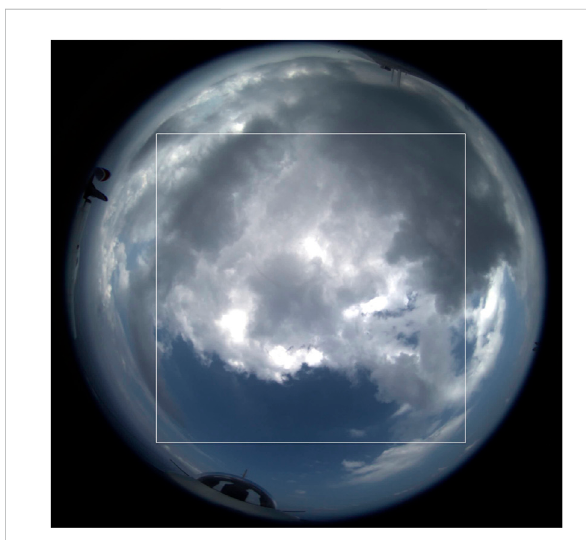
FIGURE 2 Example of the cropped all-sky camera zenith-viewing imagery, from CAMP 2 Ex fl ight 21-09-2019. The images are cropped to remove clouds near the edge of the camera and the black border on the image.